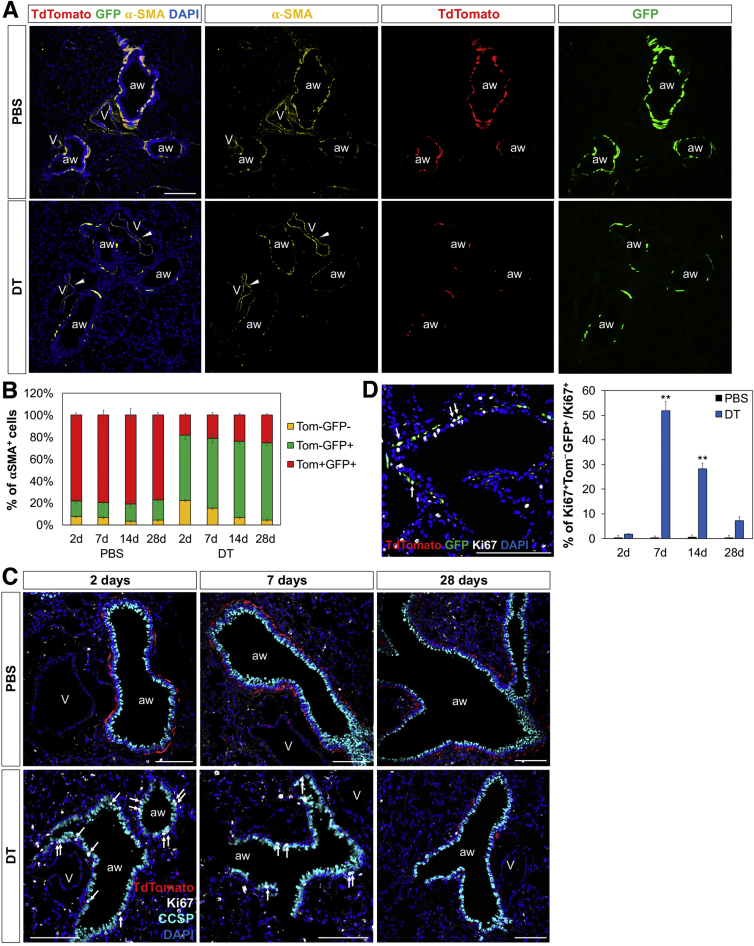
Proliferation of Lgr6-Expressing Cells following Targeted Injury of Lgr6+ Cells, Related to Figure 4(A) Representative confocal images showing the specific ablation of airway smooth muscle cells (ASMCs) marked by Lgr6 at 2 days post PBS (upper panels) or DT (lower panels) administration: Tdtomato (red), α-SMA (yellow), GFP (green), and DAPI (blue). Arrowhead, vascular smooth muscle cells.(B) Graphs to show the mean percentage of lineage-labeled Lgr6+ cells (Tom+GFP+, red bar), non-labeled Lgr6-expressing cells (Tom–GFP+, green bar), and Lgr6-negative cells (Tom–GFP–, yellow bar) that express α-SMA at indicated time points after PBS or DT treatment.(C) Representative confocal images showing proliferation of club cells after PBS (upper panels) or DT (lower panels) administration in Lgr6-CreERT2;R26-Tom;R26-iDTR mice: Tdtomato (for Lgr6, red), Ki67 (white), CCSP (cyan) and DAPI (blue). Arrow, Ki67+ club cells.(D) Representative confocal images (left) and graph (right) showing proliferation of Lgr6-expressing cells (Tom–GFP+) that were not tagged at 7days after DT administration (left): Tdtomato (red), Ki67 (white), GFP (green), and DAPI (blue). Arrow, Ki67+ Lgr6-expressing cells. Graphs to show the mean percentage of non-labeled Lgr6-expressing cells that express Ki67 at indicated time points after PBS (black bars) or DT (blue bars) treatment. Data represent the mean of percentage from three individual mice per group (at least five sections). Error bars indicate standard deviation (∗∗p < 0.005). Scale bars, 100um.